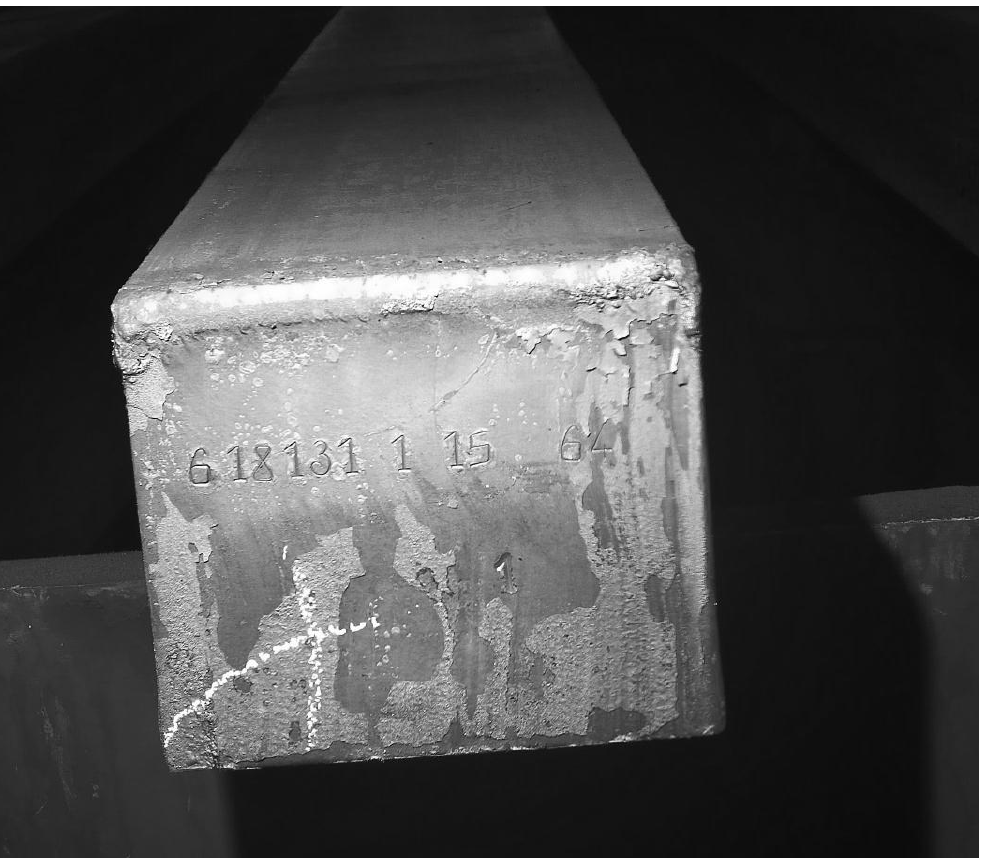
Figure 6. A billet with digits stamped onto one